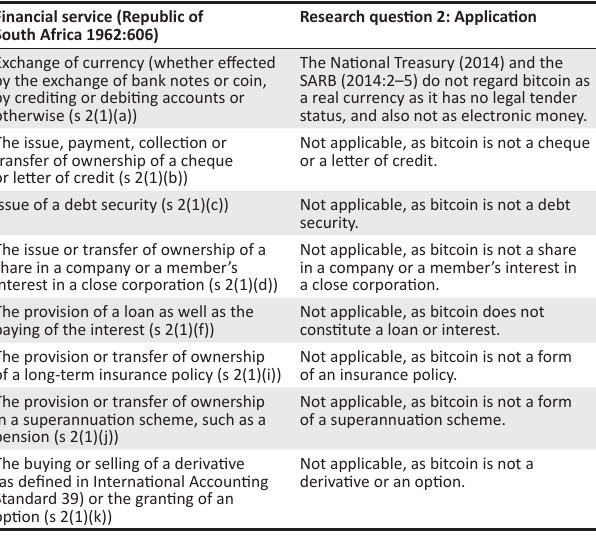
Research question 2: